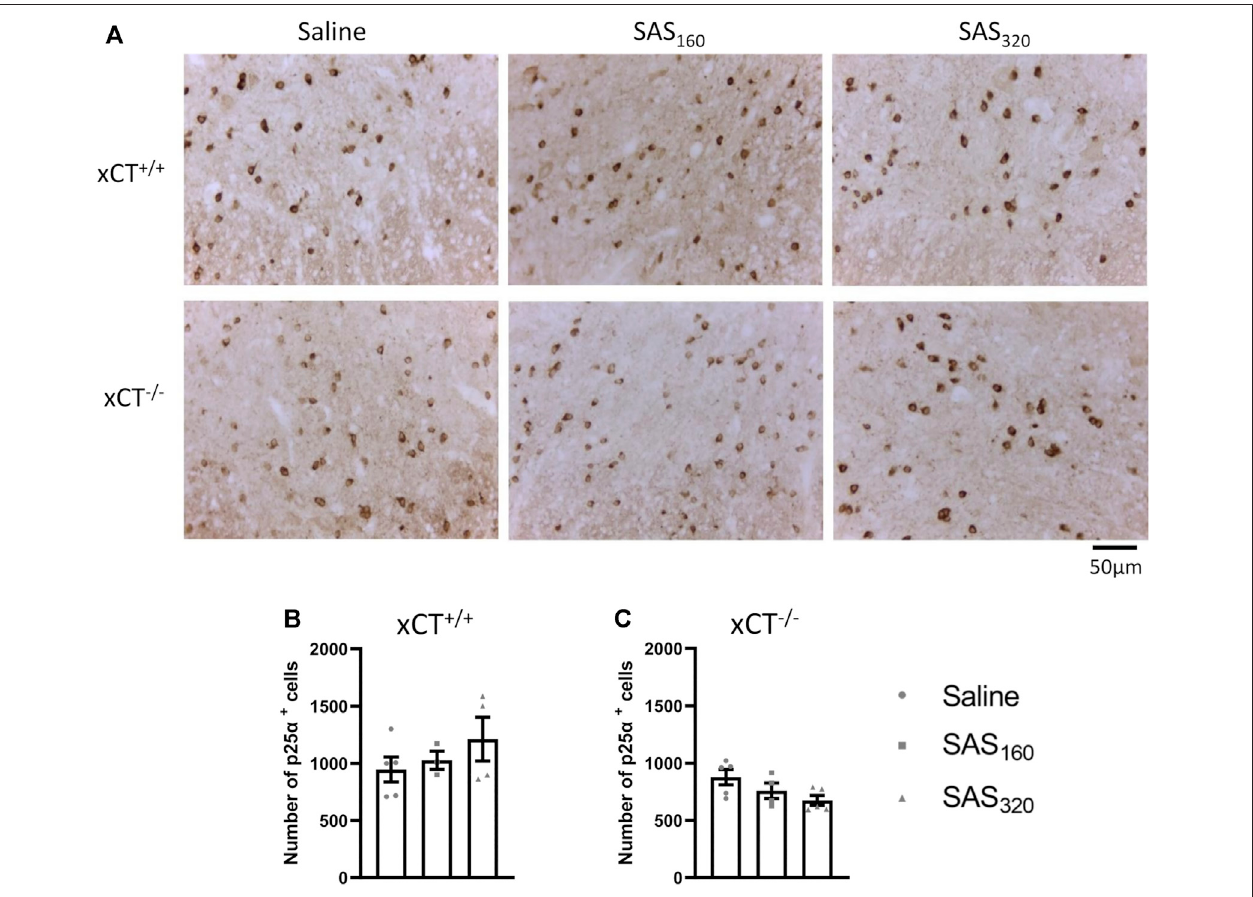
FIGURE7 | Effects ofchronic sulfasalazine (SAS) treatment on oligodendrocytes in the spinal cord. Representative photomicrographs (A) and quanti fi cation (B,C) of p25 α immunostaining to analyze oligodendrocytes. One slice of n (cid:2) 3 – 5 mice/group was used, data are presented as mean ± SEM and analyzed using a Kruskal- Wallis test followed by Dunn ’ s multiple comparisons for each dose of SAS compared to